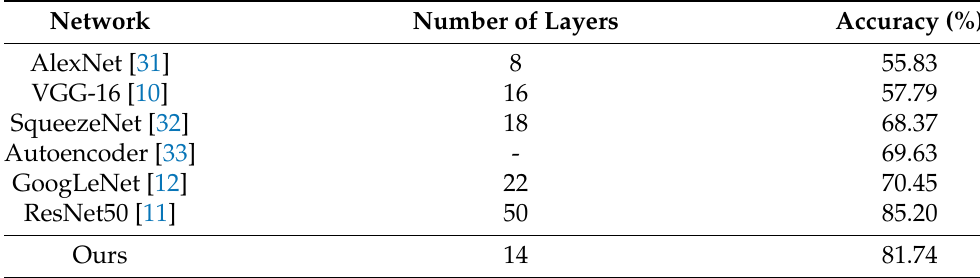
Table 5. Comparison of our network with state-of-the-art